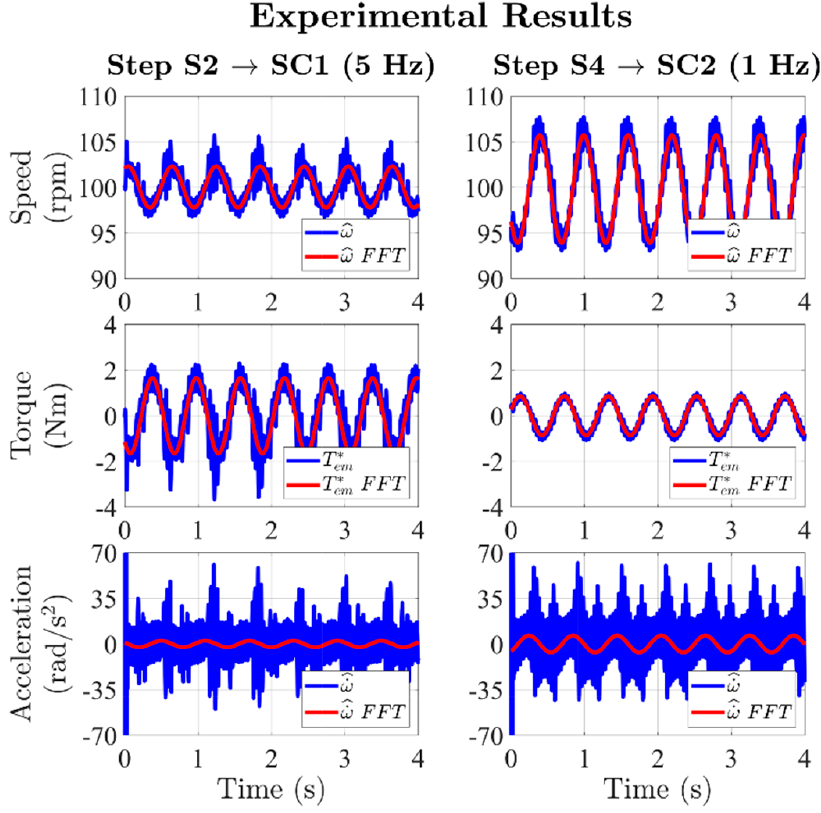
Figure 19. Experimental waveforms for implementation steps S 2 and S 4 .